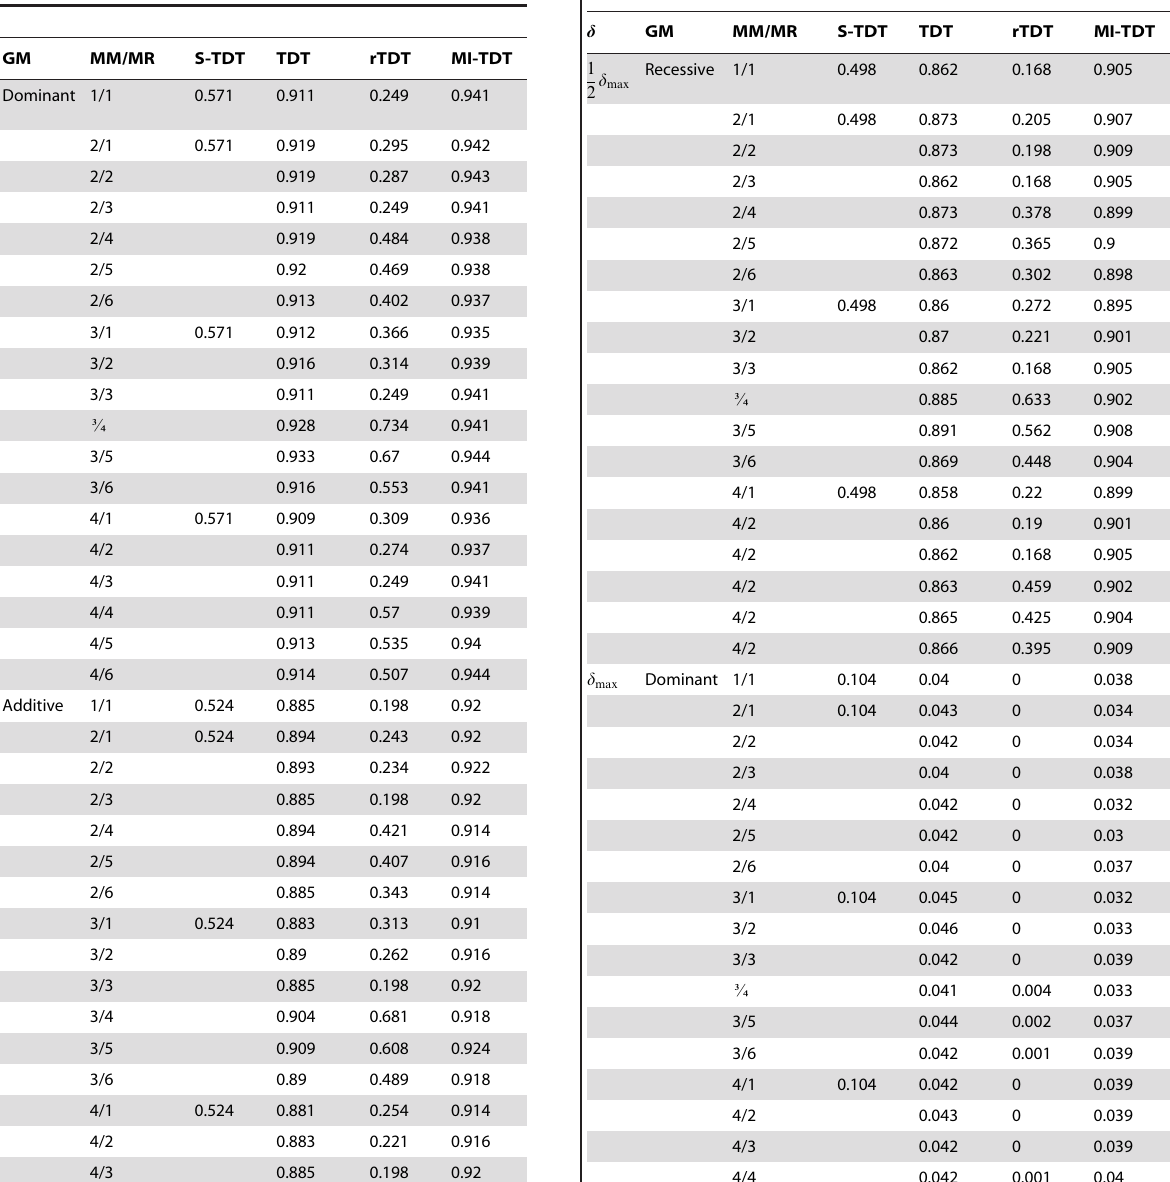
Table 14. Power analysis